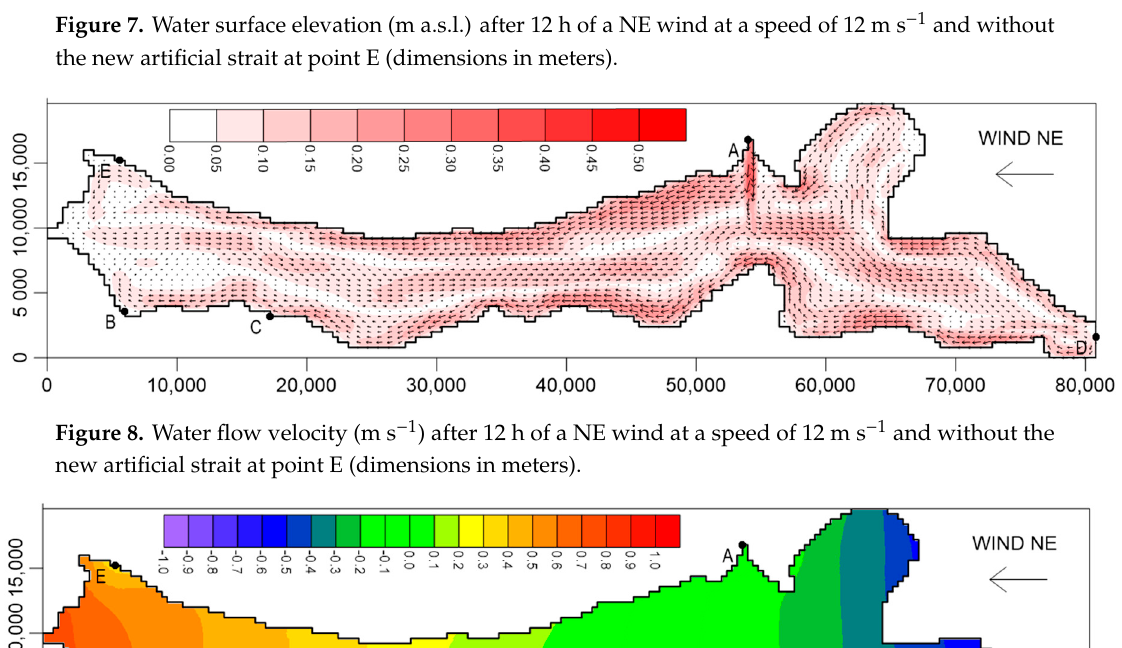
Figure 10. Water flow velocity (m s -1 ) after 12 hours of a NE wind at a speed of 12 m s -1 and with the new artificial strait at point E (dimensions in meters). Figure 11. Water surface elevation (m a.s.l.) after 12 hours of a SW wind at a speed of 12 m s -1 and without the new artificial strait at point E (dimensions in meters). Figure 12. Water flow velocity (m s -1 ) after 12 hours of a SW wind at a speed of 12 m s -1 and without the new artificial strait at point E (dimensions in meters).